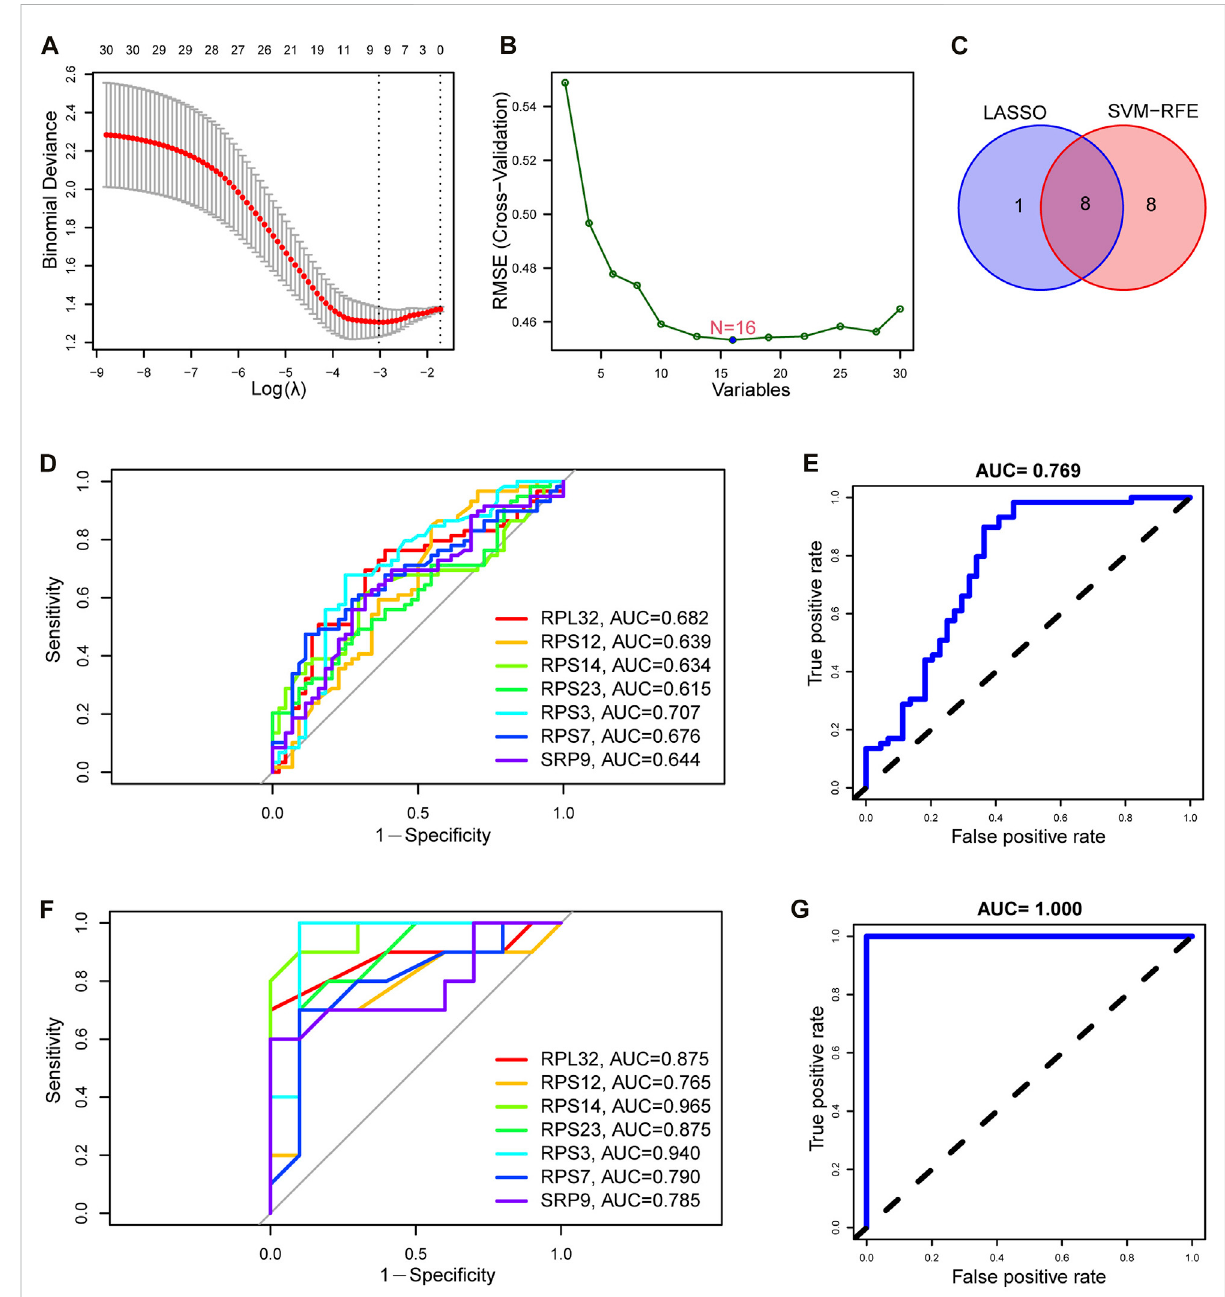
FIGURE 7 Identi fi cation and validation of SRP-DGs. (A) Screening of SRP-associated diagnostic markers using the LASSO regression algorithm. (B) Screening of SRP-associated diagnostic markers using the SVM-RFE algorithm. (C) Venn diagram showing the intersection of SRP-associated diagnostic markers screened by both algorithms. (D) ROC curves for the seven SRP-DGs in the training set. (E) The ROC curve for the combined diagnosis of seven SRP-DGs in the training set. (F) ROC curves for the seven SRP-DGs in the test set. (G) The ROC curve for the combined diagnosis of seven SRP-DGs in the test